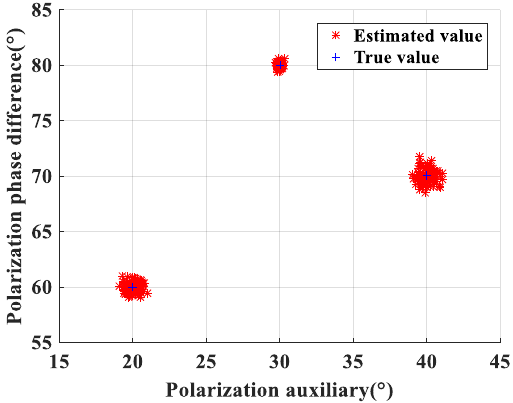
Figure 5. Planisphere of the polarization auxiliary angle and the polarization phase difference: SNR = 20 dB, snapshot number = 1000, ( γ 1 = 30 ◦ , η 1 = 80 ◦ ) , ( γ 2 = 20 ◦ , η 2 = 60 ◦ ) , ( γ 3 = 40 ◦ , η 3 = 70 ◦ )